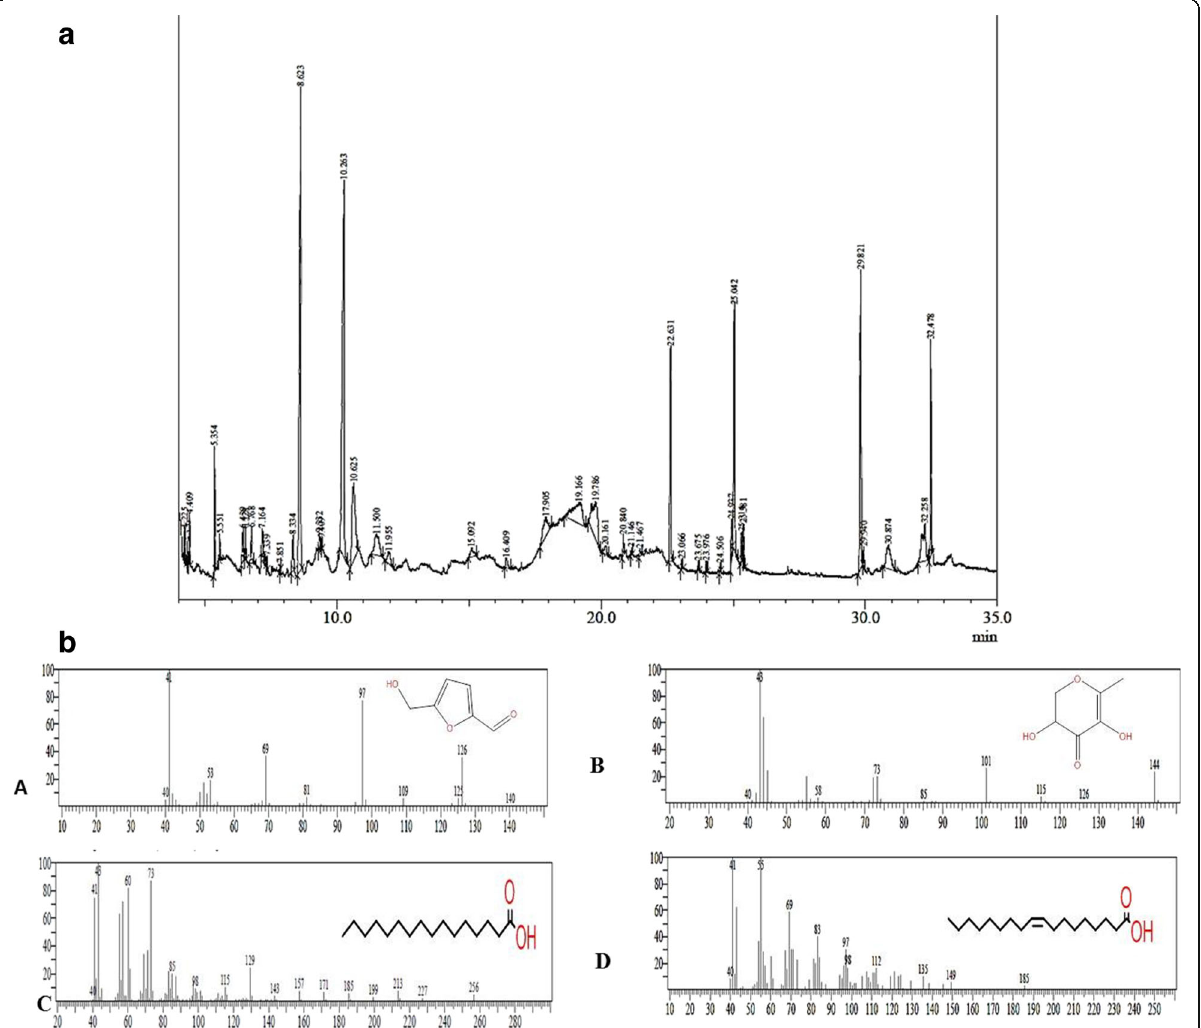
Fig. 1 a .GC-MS Chromatogram of PTY-2r. b Spectra of major compounds ( A ) Spectra of 2, 3-dihydro-3, 5-dihydroxy-6-methyl-4H-pyran-4-one, ( B ) Spectra of 5-Hydroxymethylfurfural, ( C ) Spectra of n-Hexadecanoic acid ( D ) Spectra of 9-Octadecenoic acid